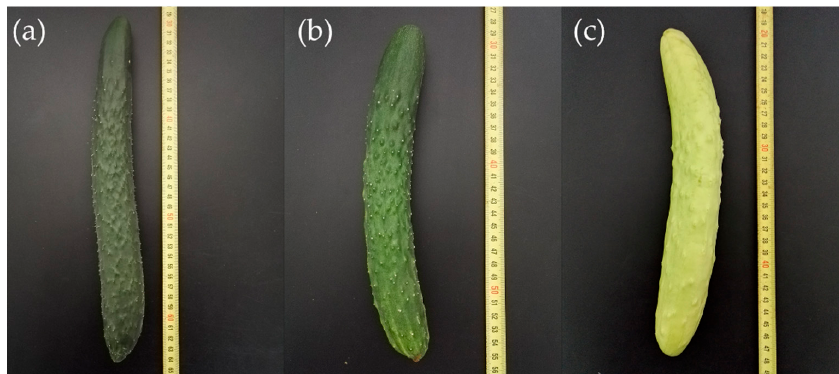
Figure 1. Immature fruit skin color of the parental lines and their progeny: ( a ) A green-skinned cucumber inbred line Q1 (P 1 ); ( b ) A green-skinned F 1 population of H4 × Q1; ( c ) A white-skinned line H4 (P 2 ). Table 1. Segregation of immature fruit color in the three populations of cucumber. Population Observation Expected χ 2 p Value Separation Ratio Green White BCP 1 a 120 0 1:0 - - BCP 2 b 65 55 1:1 0.68 0.411 F 2 c 115 29 3:1 1.56